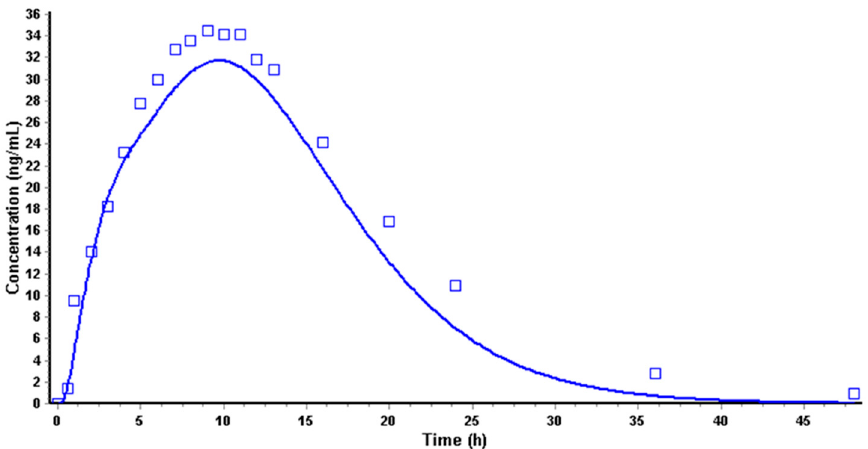
Figure 10. Observed (squares) and simulated (lines) plasma concentration-time curves of a 95 mg